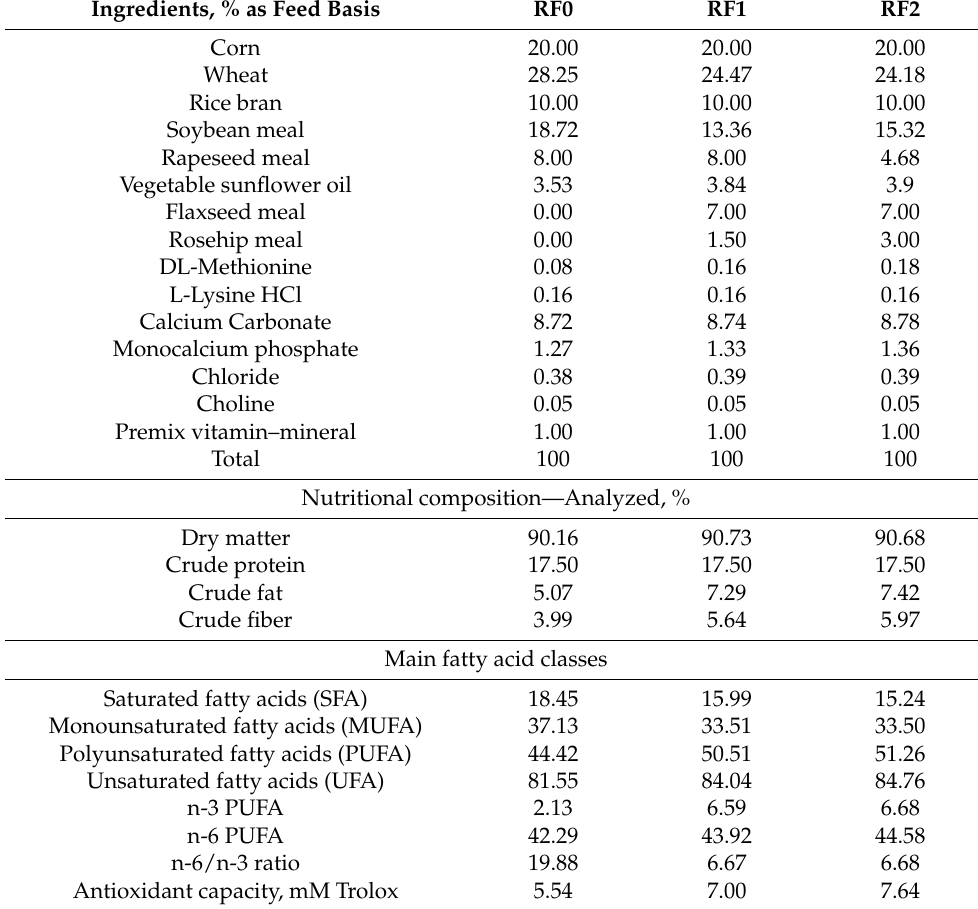
Table 1. Ingredients and nutritional composition of the